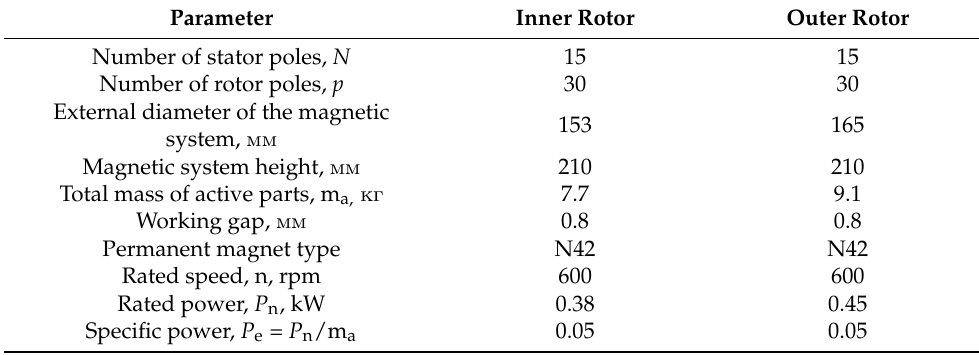
Table 4. Basic parameters of three-phase electric machines with an inner rotor and an outer